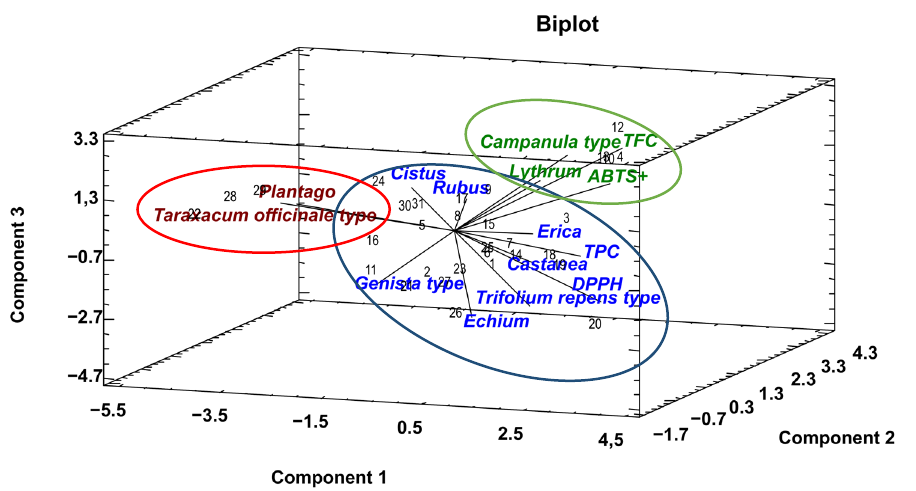
Figure 4. Dendrogram of cluster analysis with the distribution of bee pollen samples (1: group 1; 2: group 2; 3: group 3). The first group (1) included six pollen samples with significantly higher percentages in Erica (20.1%), Campanula type (14.5%), Lythrum (11.5%), significantly higher in TFC (454.1 mg/100 g) in comparison to the other two groups (two and three), and DPPH (69.3%) respect to group three (21.0%) (Table 4). In group two, there is the largest number of pollen samples (22) and it was characterized by significantly higher mean percentage in the Genista type (12.1%), Castanea (28.4%) and Rubus (37.7%) pollen types, TPC (1741.4 mg/100 g), TFC (219.2 mg/100 g) and antioxidant activity (70.8%) compared to group three (21.0%). Finally, group three (with three bee pollen samples) included the samples with the significantly lower mean values in TPC, TFC and DPPH, but significantly higher pro ‐ portions of the pollen types Taraxacum officinale type (50.2%) and Plantago (24.3%).